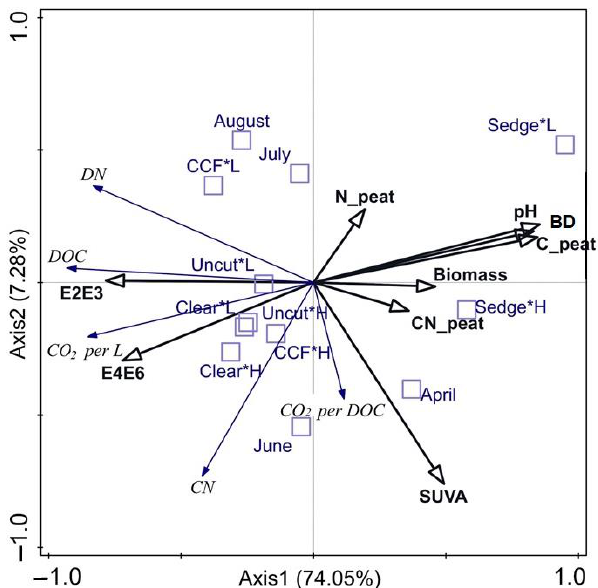
Figure 3. RDA-all-in. A constrained analysis using CO 2 data (expressed as CO 2 per L and CO 2 per DOC), and the measured pore water C and concentrations are used as response variables (italics; blue arrows). The peat properties and pore water spectral data were used as explanatory variables (bold; black arrows). Month and the interaction factor of management and water table treatment were used as supplementary variables (blue boxes). CO 2 per L = CO 2 production per volume ( µ g CO 2 L − 1 day − 1 ) on the first three days of incubations (T3); CO 2 per DOC = CO 2 production per measured DOC ( µ g CO 2 -C DOC − 1 d − 1 ) on the first three days of incubations (T3); C_peat = C concentration of dry peat; N_peat = N concentration of dry peat; CN_peat = peat C:N-ratio; BD = peat dry bulk density (g cm − 3 ); Biomass = total photosynthesizing aboveground dry biomass (g); L = low water table; H = high water table; clear = clear-cut; CCF = continuous cover forest.